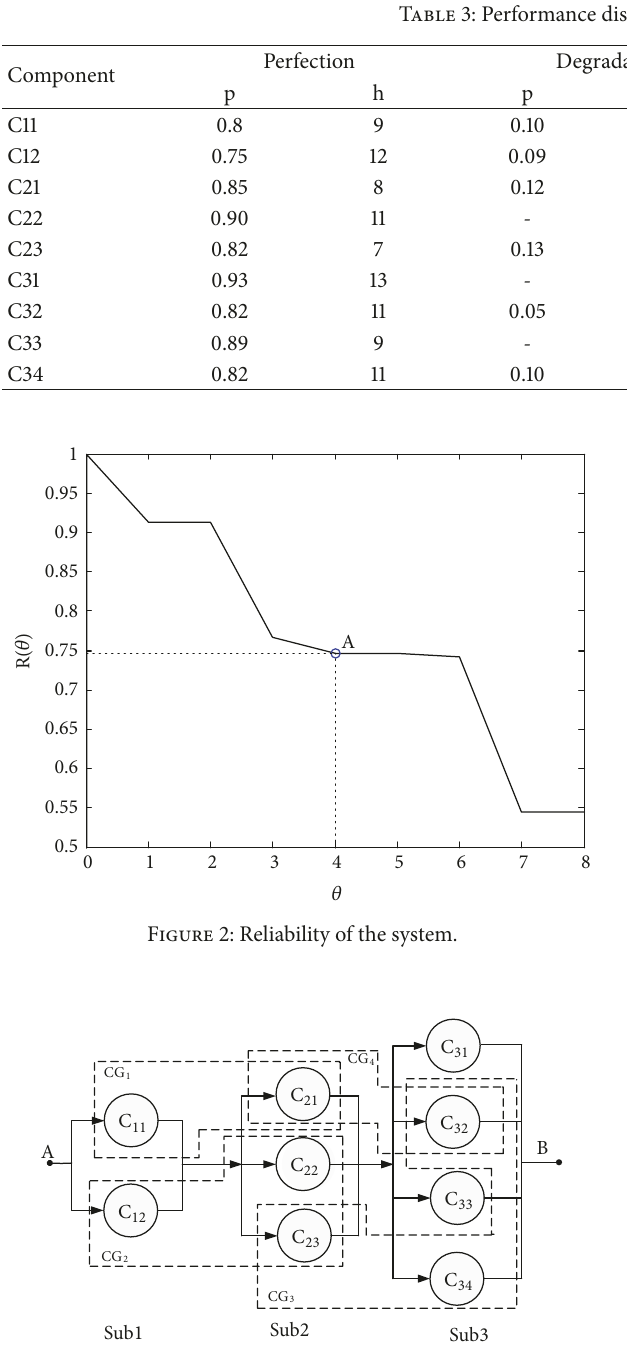
Figure 3: An MSS production system.